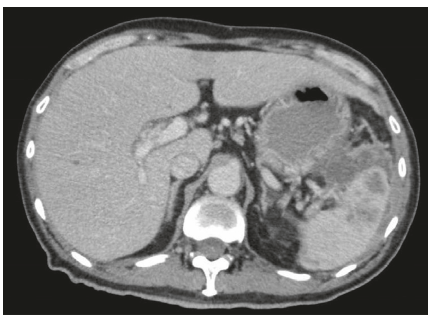
Figure 1: Computed tomography image of splenic